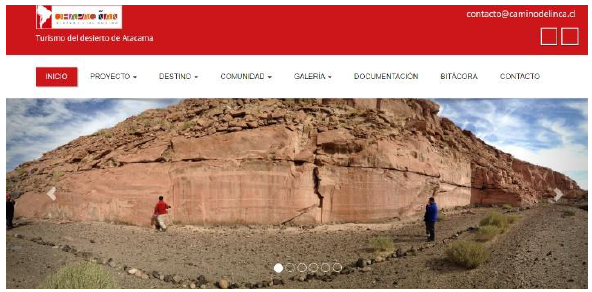
Figure 5. Routes of the Qhapaq Ñan, Chile. © Qhapaq Ñan Sistema Vial Andino. Image: Screen capture, 2017. Proyecto Qhapaq Ñan - Desierto de Atacama,